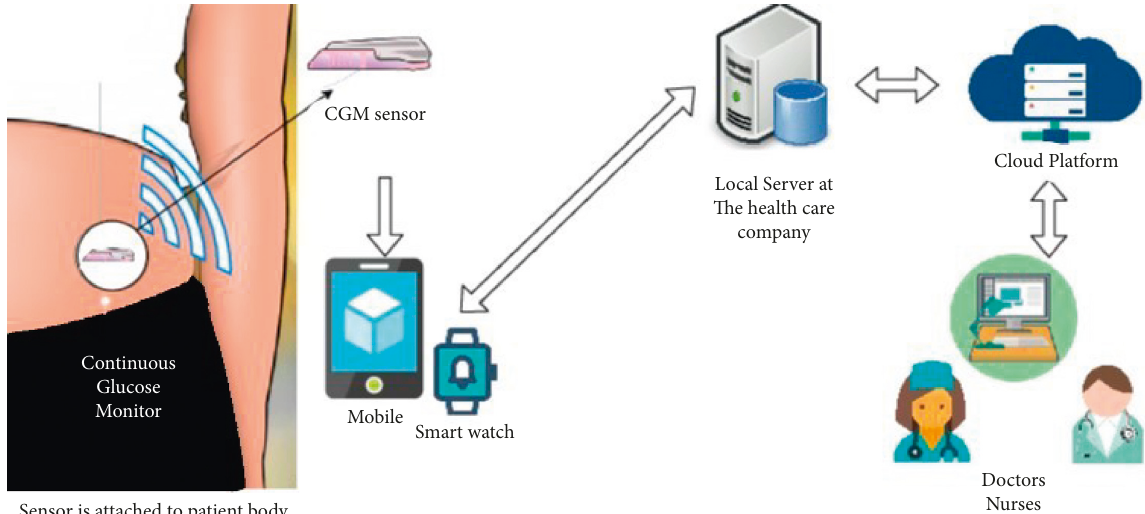
Figure 2: IoT application in supporting diabetes treatment monitoring